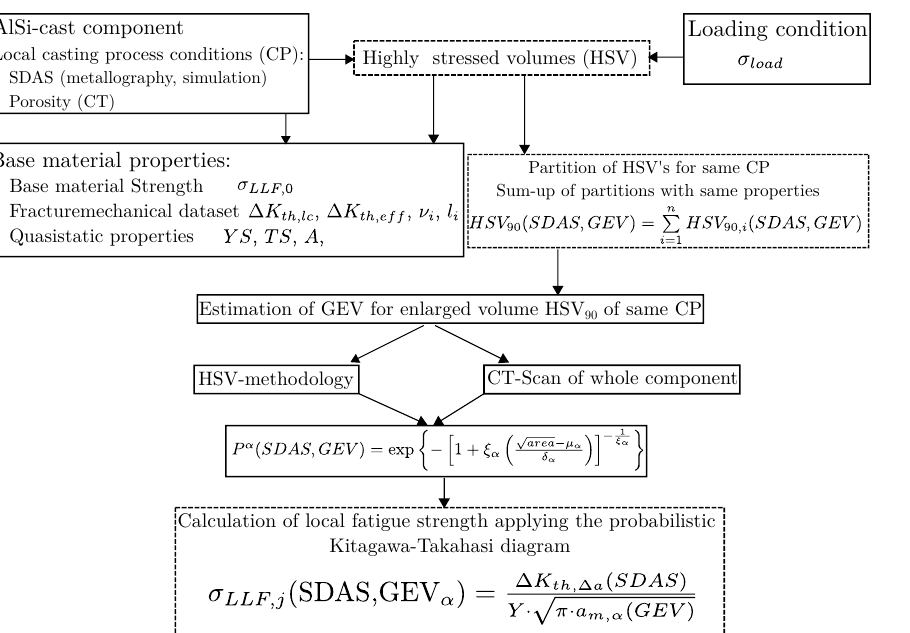
Figure 16. Flowchart of setting up the layer-based assessment